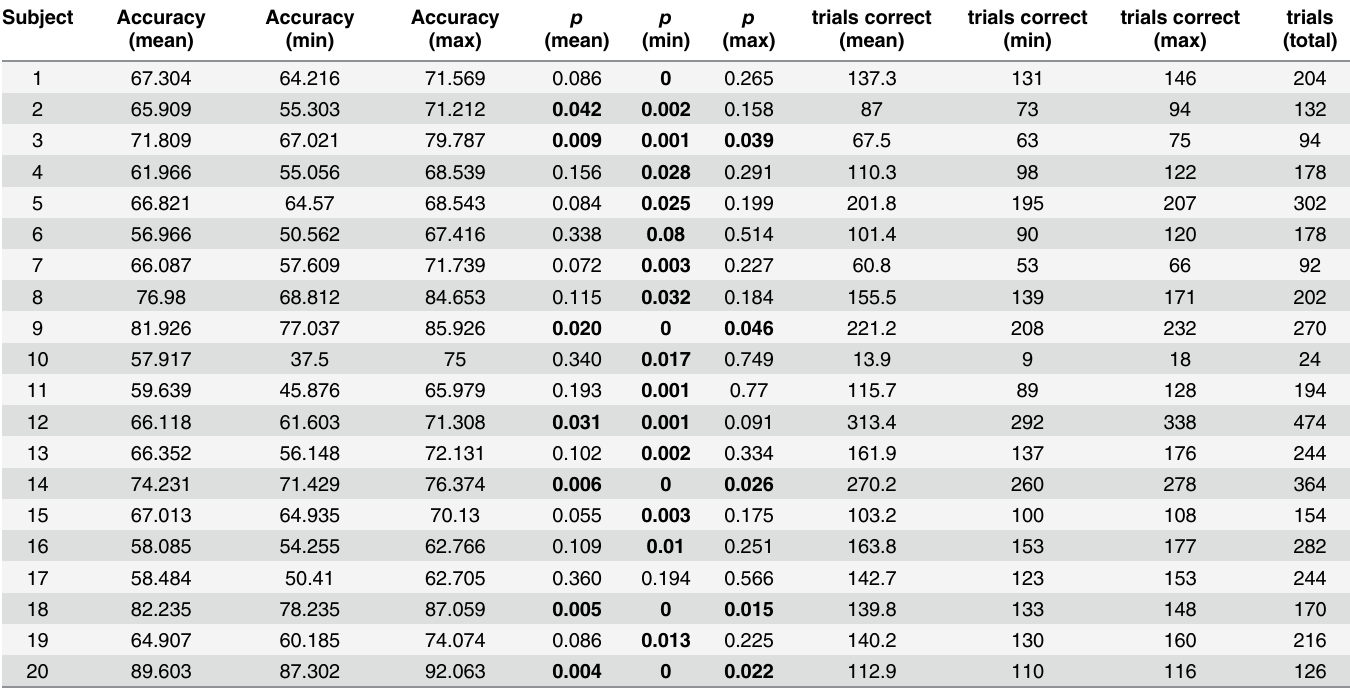
Table 12. Results Across Task Pe: Train Rotation, Classify